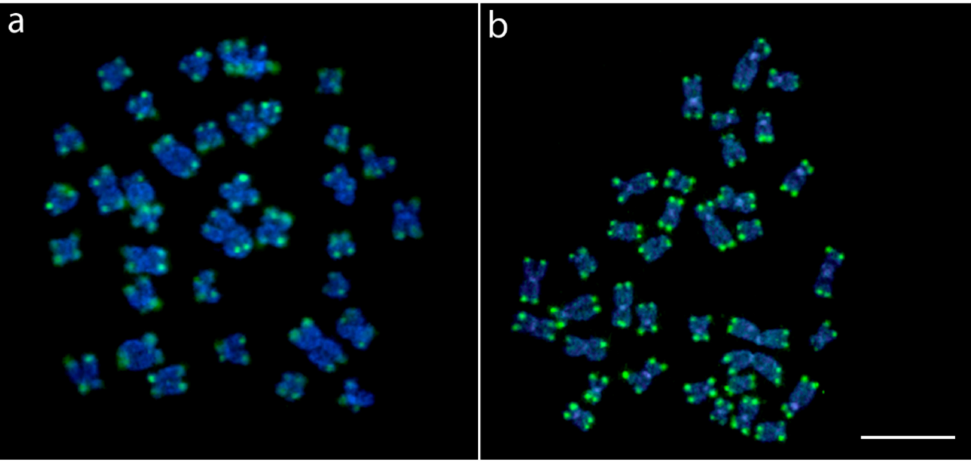
Figure 4. Female metaphase plate of Lebiasina bimaculata ( a ) and Lebiasina melanoguttata ( b ) showing the distribution of the telomeric (TTAGGG)n repeats. Bar = 5 µ